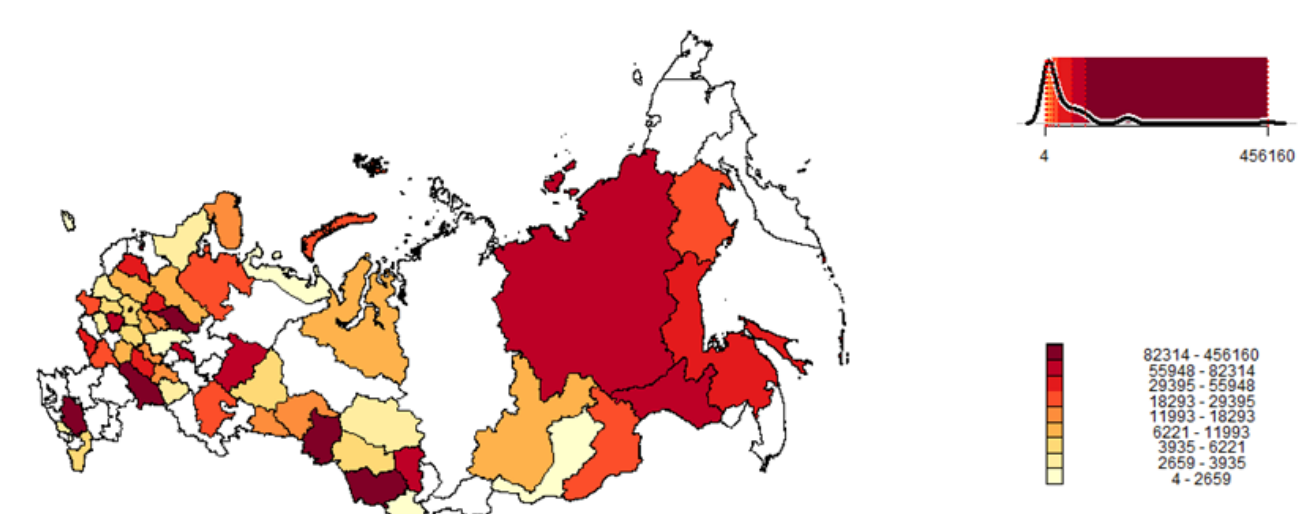
Fig.1: The Russian health centers – geographical distribution.